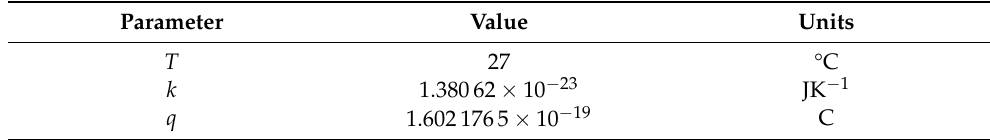
Table 2. Default parameters for the calculation of the thermal voltage, V t , utilised in the SPICE LSDM. From [18,26].